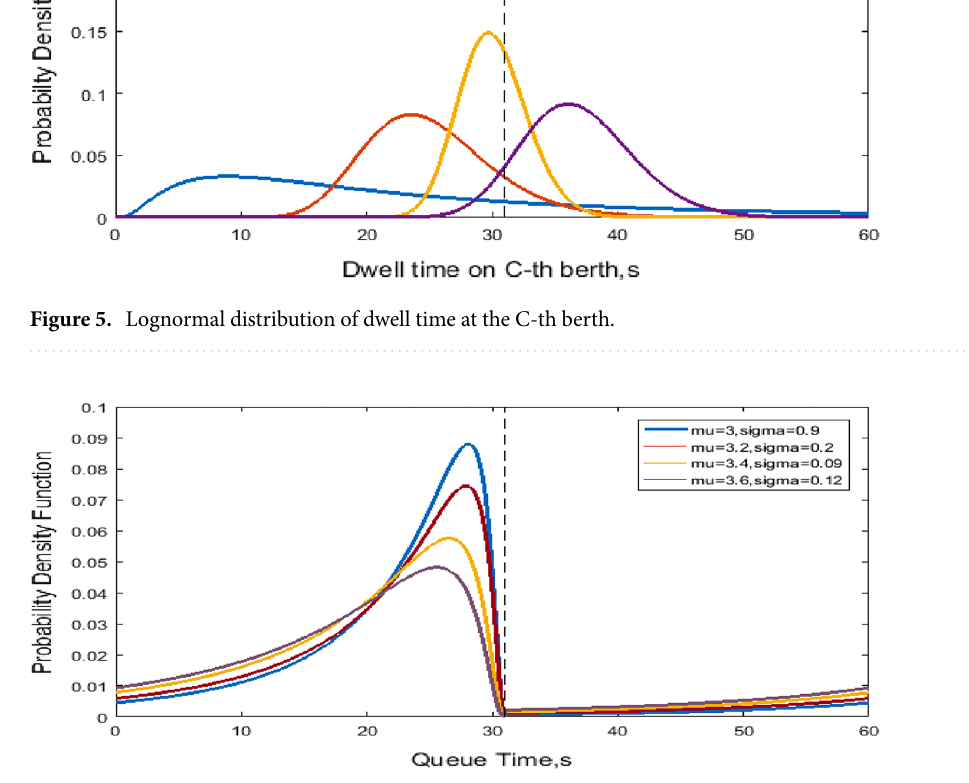
Figure 6. Truncated lognormal distribution of queue